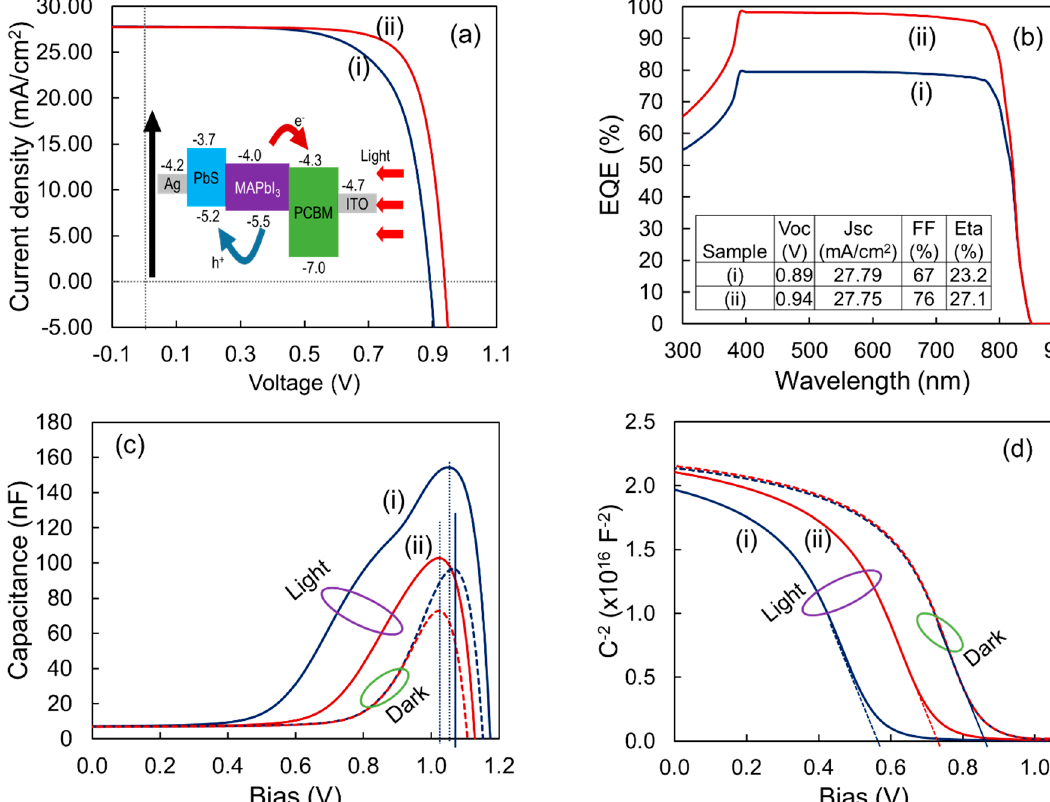
Figure 7. ( a ) The light current density-voltage (J–V) curves found for PSCs with different PbS thin films, ( b ) shows the quantum efficiency (QE) for the PSCs, ( c ) and ( d ) shows the light and dark capacitance-voltage (C–V) curves for the modeled PSCs (inset: ( a ) shows the schematic band diagram and ( b ) shows the performance parameters of modeled PSCs and (i) and (ii) is indicate the PSCs with two different PbS films that have been deposited using 5 mg mL − 1 and 10 mg mL − 1 of solution concentration).